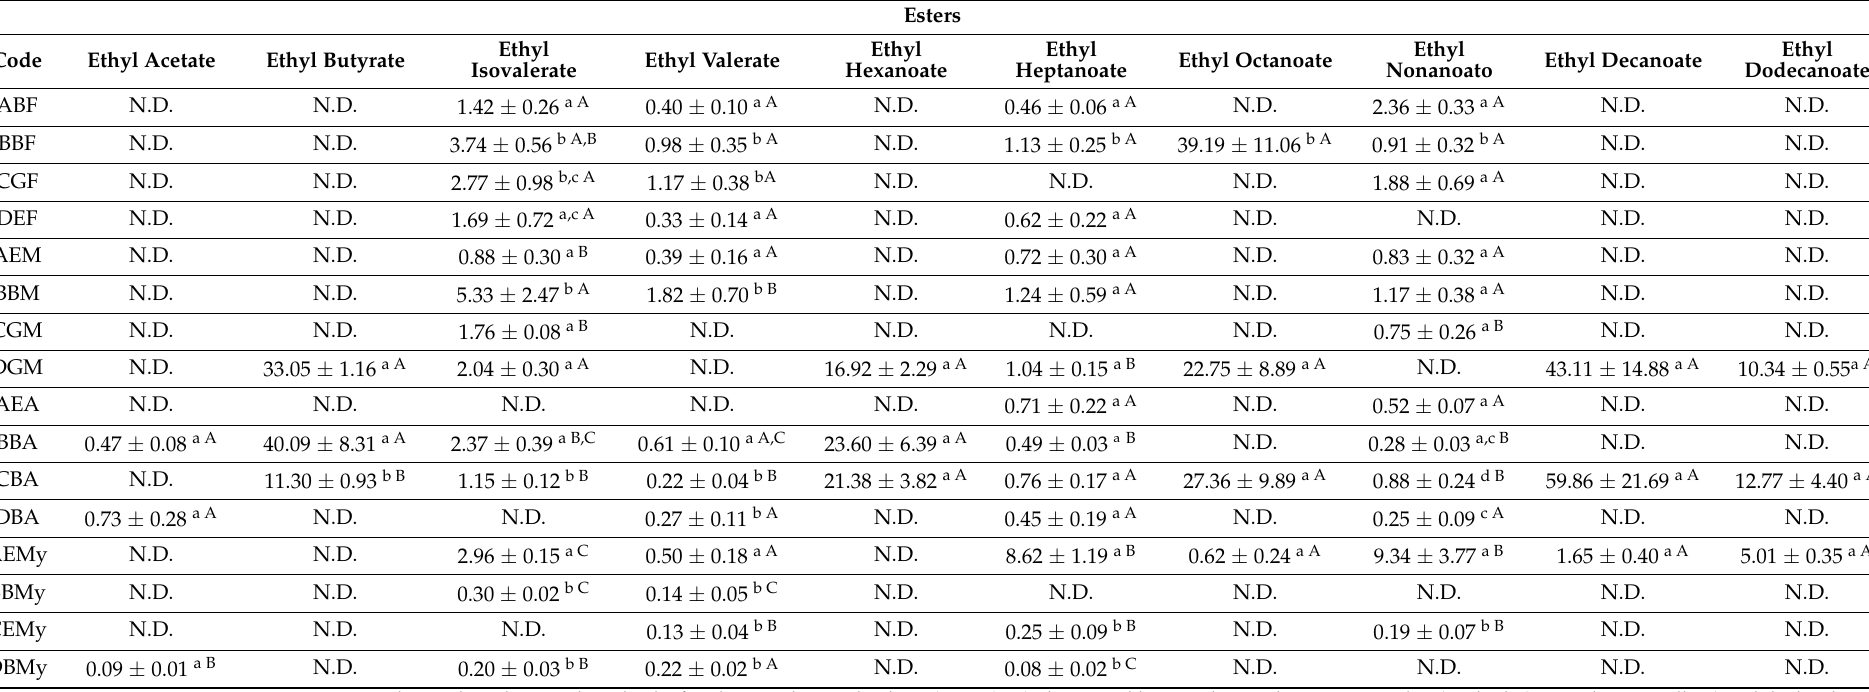
Table 6. Volatile esters (mean ± standard deviation; mg/100 g) in samples from producers A, B, C and D, during four consecutive months of production.